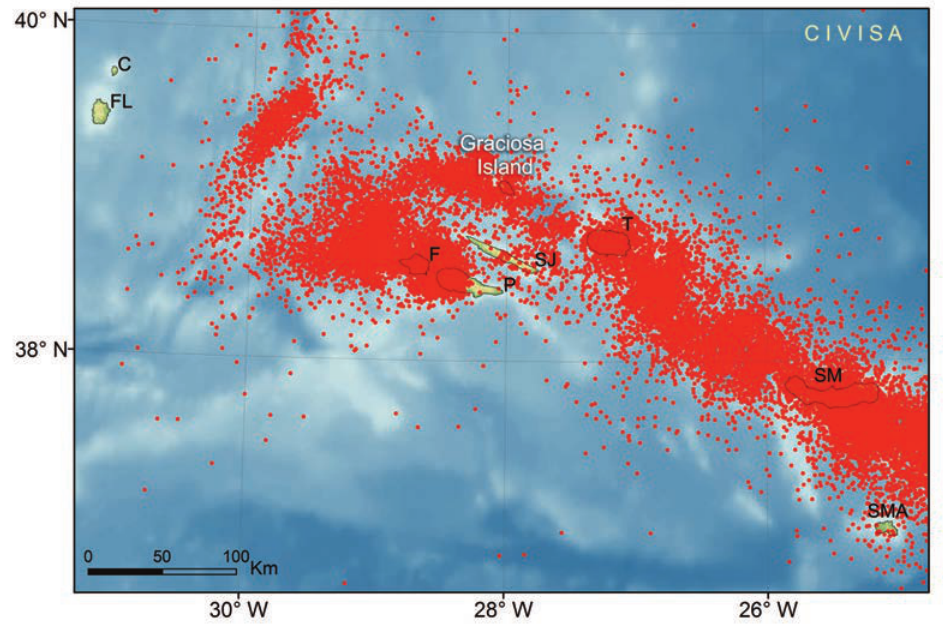
Figure 3. Seismicity in Azores region from 1980 to 2012. The red dots mark epicentres of earthquakes. Plot includes earthquakes of all mag- nitudes. Acronyms as in Figure 1. Data from CIVISA (Centro de Informação e Vigilância Sismovulcânica dos Açores),